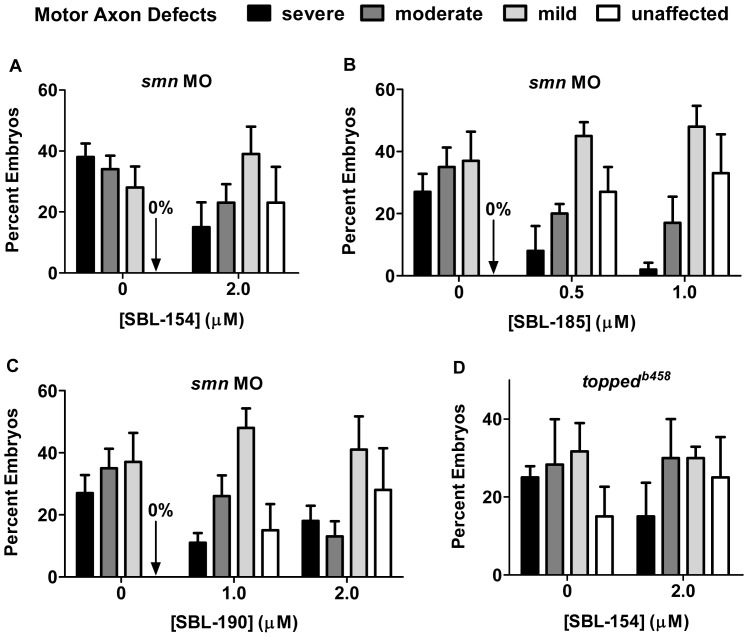
Rescue of motor axon development by axonotrophic compounds; combined results.(A) The results with 2 µM SBL-154 were averaged across the experiments in Figure 7A–F for both the control (vehicle-treated embryos) and experimental conditions, and mean values are plotted along with SEM (N = 6). SBL-154 significantly reduced the severity of motor axon defects (p<0.0001, N = 6; Mann-Whitney U test). (B) Suppression of Smn knockdown by SBL-185 was tested in 5 experiments, each of which examined 3 conditions: 0.5 µM SBL-185 (95 embryos scored among the 5 experiments, with about 20 embryos per experiment), 1 µM SBL-185 (95 embryos), and DMSO vehicle (99 embryos). Both concentrations of SBL-185 significantly reduce the severity of motor neuron dysmorphism (p<0.0001, N = 5; Kruskal-Wallis one-way ANOVA). (C) Suppression of Smn knockdown by SBL-190 was tested in 5 experiments, each of which examined 3 conditions: 1 µM SBL-190 (88 embryos), 2 µM SBL-190 (88 embryos), and DMSO vehicle (99 embryos). Both concentrations of SBL-190 significantly reduce the severity of motor neuron dysmorphism (p<0.0001, N = 5; Kruskal-Wallis one-way ANOVA). (D) Suppression of motor axon defects in toppedb458 mutants by SBL-154 was tested in 3 experiments in which mutants were treated with either DMSO (60 embryos) or 2 µM SBL-154 (60 embryos). SBL-154 showed no effect (p = 0.14; Mann-Whitney U test).